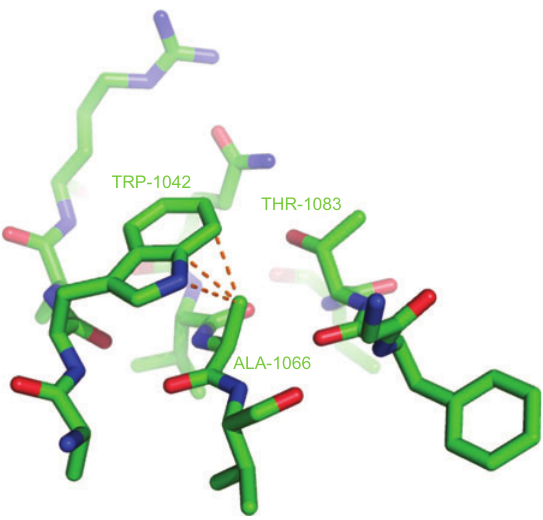
Figure 8 A model of the barrel of EspP with the mutation G1066A, based on the crystal structure, PDB 2QOM (61) . Steric clashes are shown as dashed lines. The modelled alanine side chain presses against the nearby tryptophan residue W1042, but oth- erwise causes no strain in the structure or blocks the barrel lumen. Nevertheless, the added methyl group causes a marked slowdown in EspP